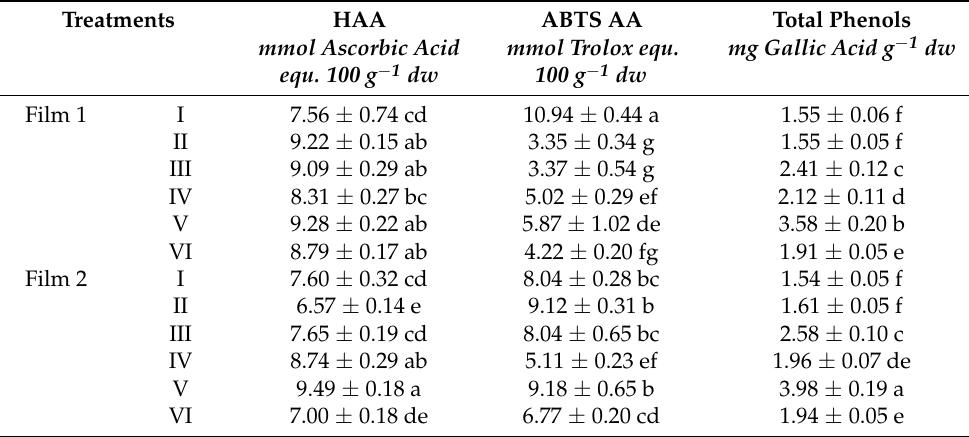
Table 7. Interaction plastic film × harvest (P × H) on the average hydrophilic antioxidant activity (HAA), ABTS antioxidant activity (ABTS AA) and content of total phenols in rocket. Different letters within each column indicate significant differences at p = 0.05 (Tukey’s